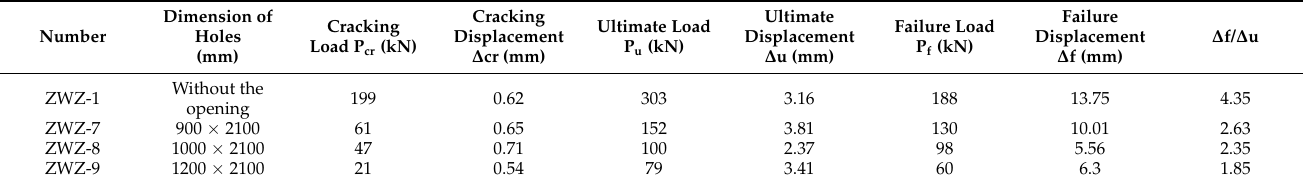
Table 9. Bearing capacity values of the walls with different door hole dimensions.